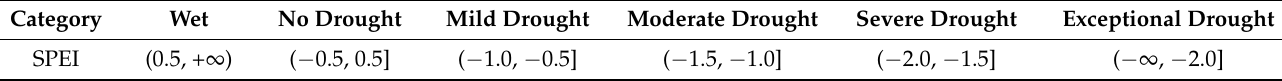
Table 1. Drought classification of the